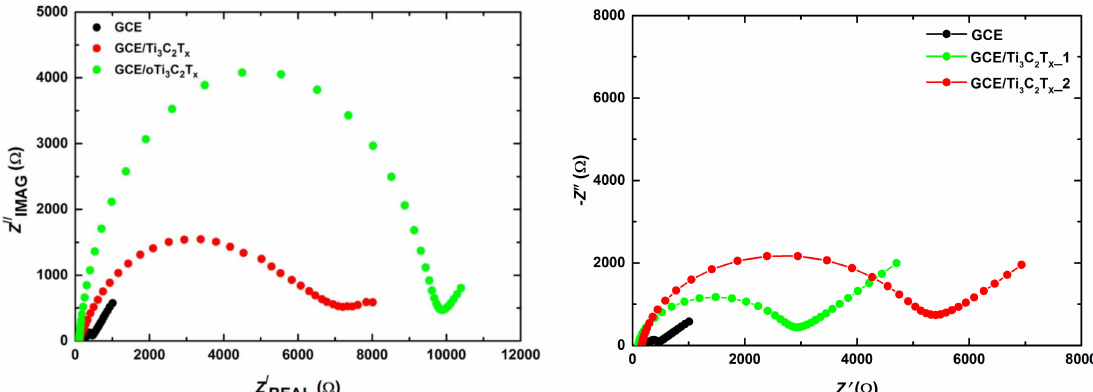
Figure 5. Nyquist plots at unmodified glassy carbon electrode (GCE), GCE / Ti 3 C 2 T x , and GCE / oTi 3 C 2 T x ( left ). Reprinted from ref. [59], Copyright (2017), with permission from Elsevier. Nyquist plots at unmodified GCE, GCE / MXene1, and GCE / MXene2 ( right ). Reprinted by permission from ref. [29]: Springer, Copyright (2020). In both cases EIS was run in 5 mM ferricyanide / ferrocyanide solution in 0.1 M PB pH 7.0. EIS spectra were run using 50 di ff erent frequencies (0.1 Hz–100 kHz). The